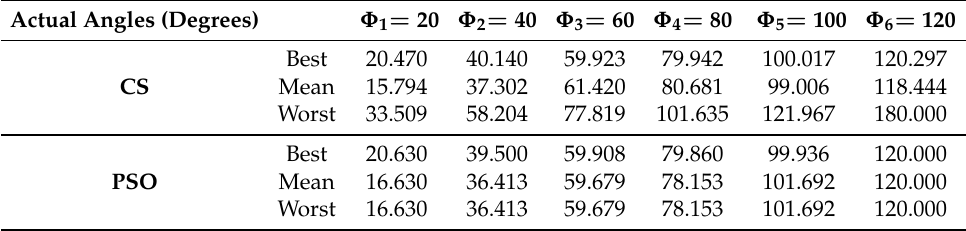
Table 3. Calculation of accuracy for six targets at − 10 dB SNR.